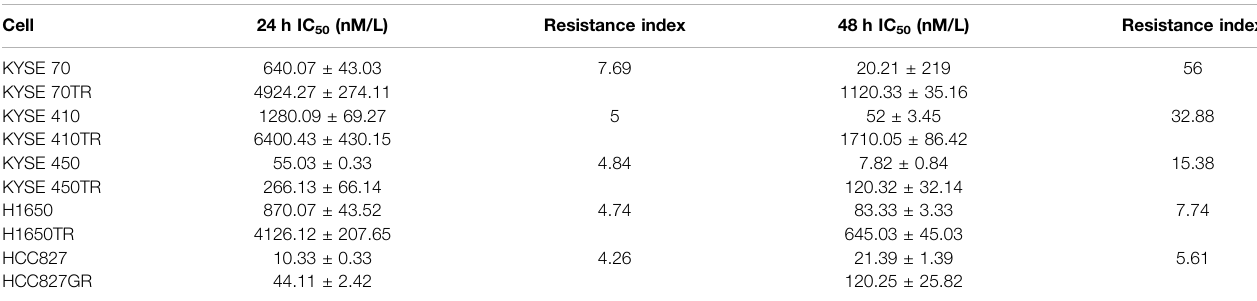
TABLE 2 | Resistance index of the fi ve drug resistance cell lines.